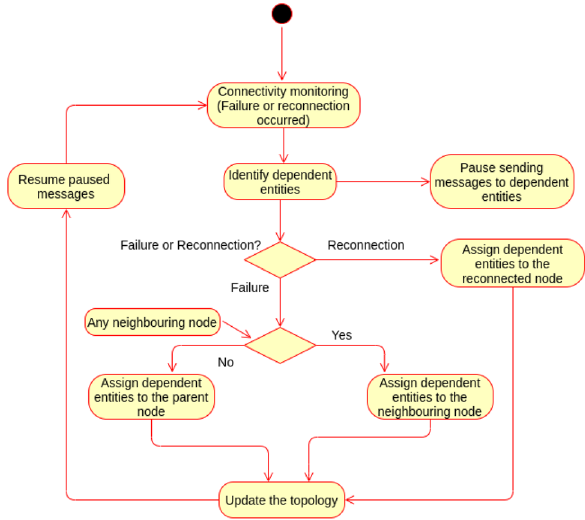
Figure 12. Actuation communication latency, SALFSD with and without layered